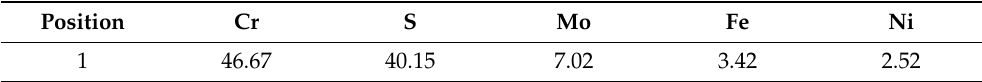
Figure 4. Metallographic microstructure of the coating. ( a ) Cladding surface, ( b ) Bonding zone, ( c ) Top of cladding, ( d ) Middle of cladding, ( e ) Bottom of cladding. Table 3. EDS composition analysis of test point in coating (atom